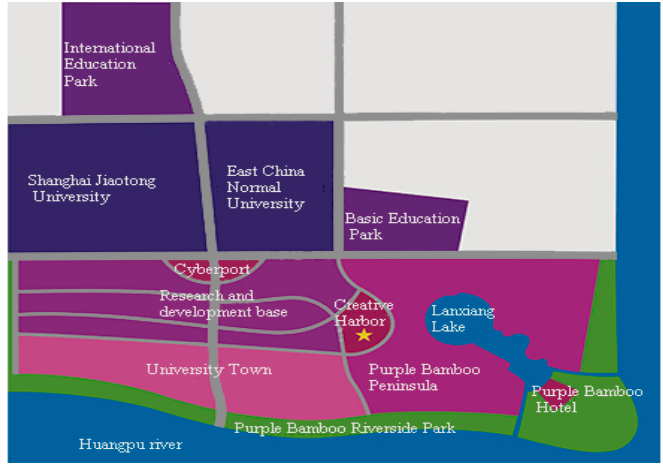
Figure 1. Overview of the functional area in the Zizhu National Hi-Tech Industrial Development Zone (ZIZHU).